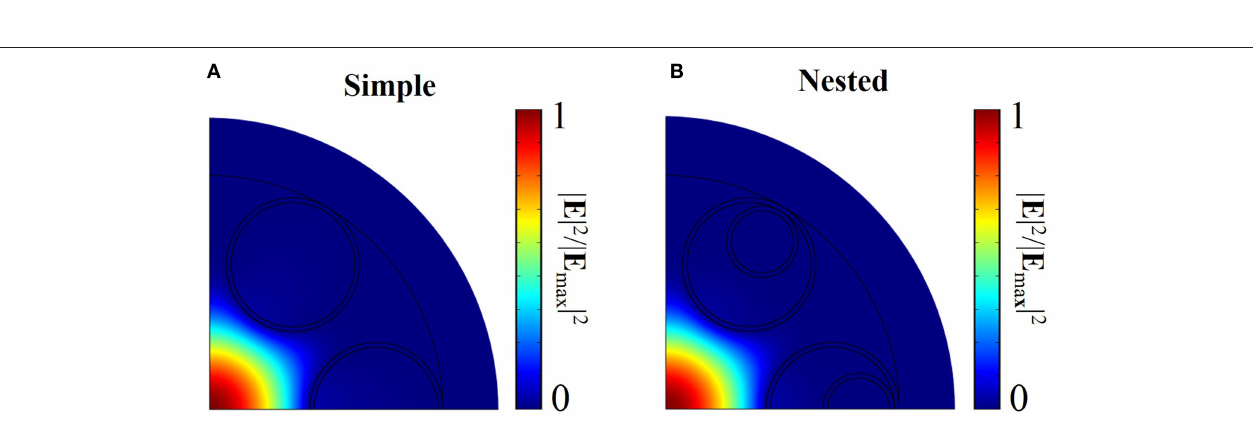
FIGURE 4 | Contour plot of fiber loss in (A) simple and (B) nested negative curvature fibers. No material loss is included.